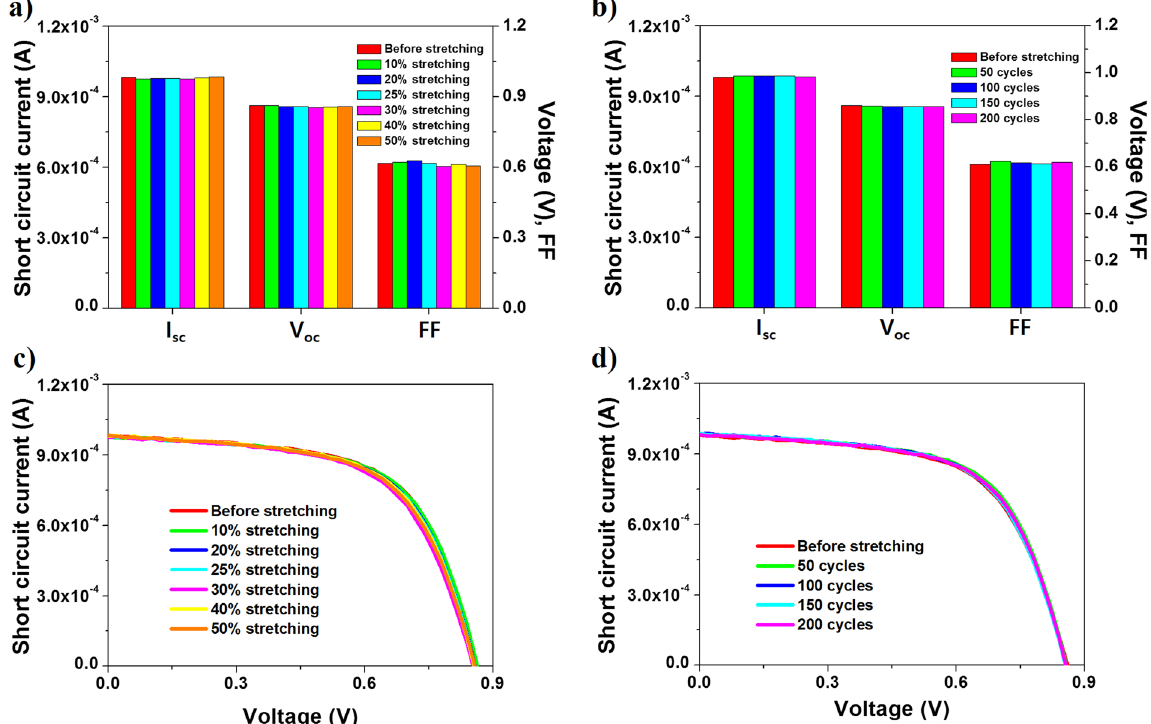
Figure 6. Photovoltaic characteristics of single buckled ribbon as a function of ( a ) tensile strain that is orthogonal to the direction of the compressive strain and ( b ) stretching cycle. Current-voltage curves of single buckled ribbon as a function of the ( c ) tensile strain that is orthogonal to the direction of the compressive strain and ( d ) stretching cycle.